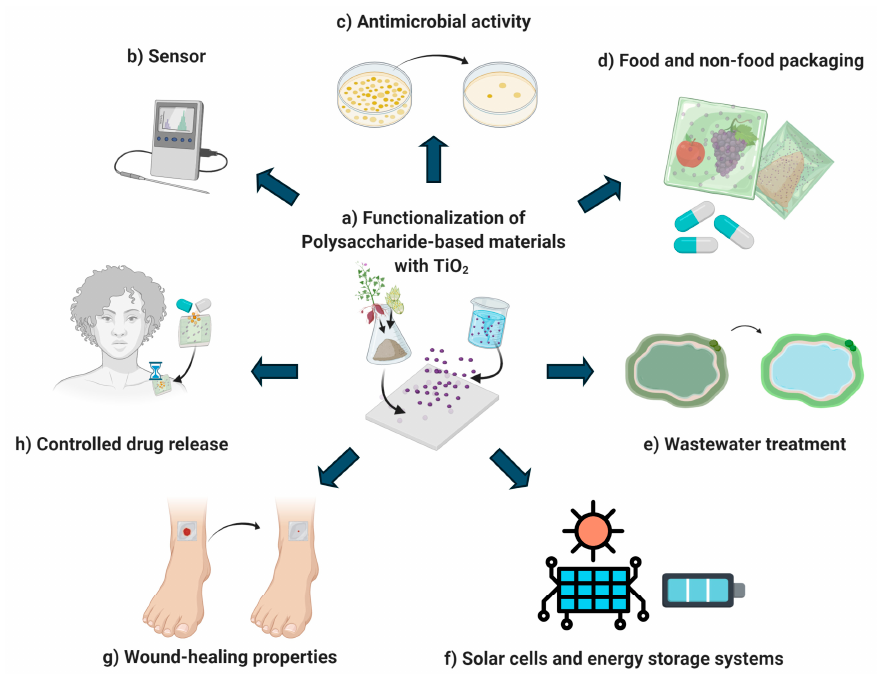
Figure 3. Schematic representation of the functionalization of polysaccharide-based materials with TiO 2 ( a ) and their main applications: sensor development ( b ), antimicrobial activity ( c ), food and non-food packaging ( d ), wastewater treatment ( e ), solar cells and energy storage systems ( f ), wound-healing ( g ), and controlled drug release ( h ) (adapted from de Moura et al. [36], Dai et al. [37], Ismail et al. [38], and Al-Morakam [39]) (Figure created in